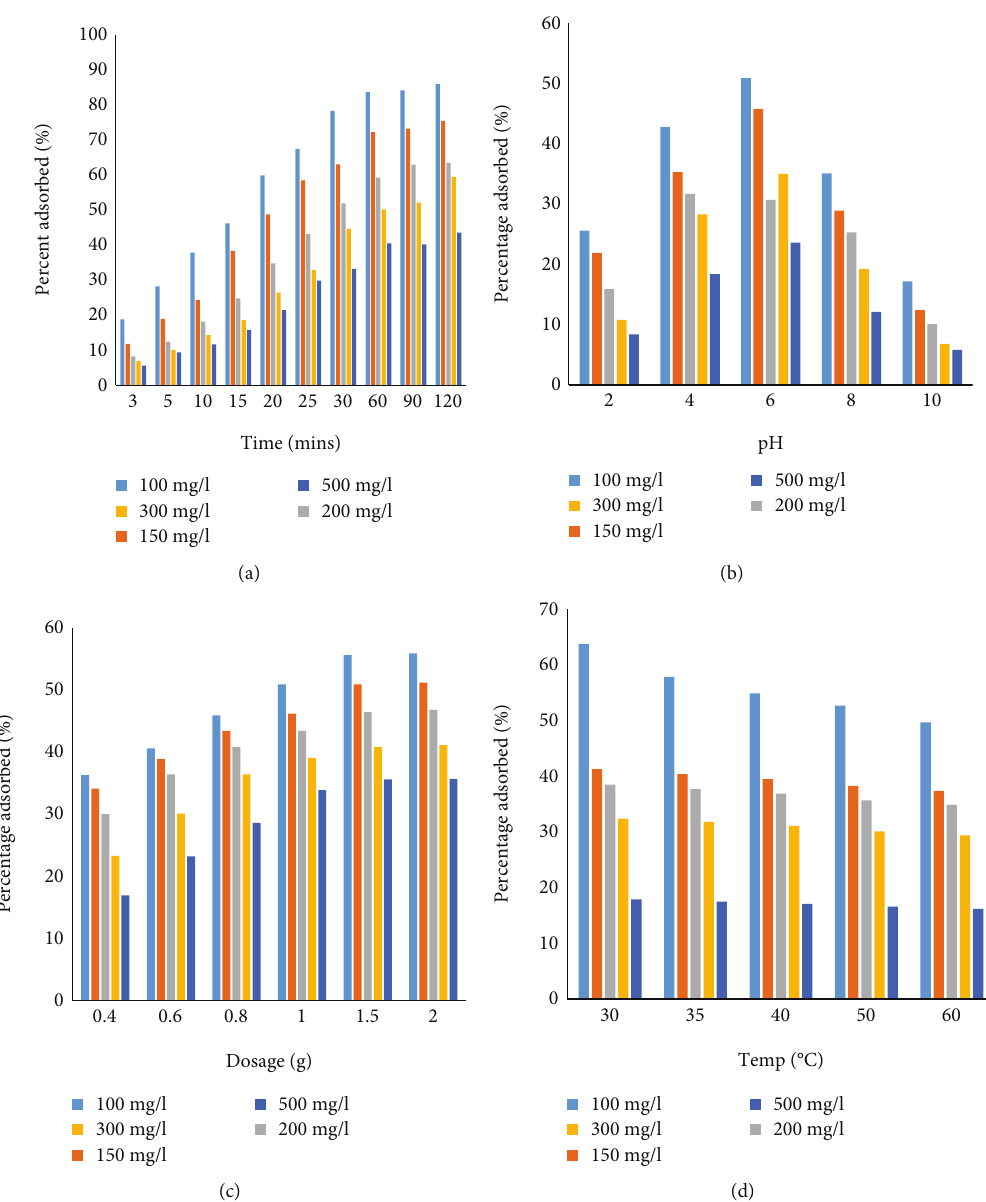
Figure 2: E ff ects of operating variables on phenol adsorption: (a) e ff ect of contact time and initial phenol concentration, (b) e ff ect of solution pH, (c) e ff ect of adsorbent dosage, and (d) e ff ect of solution